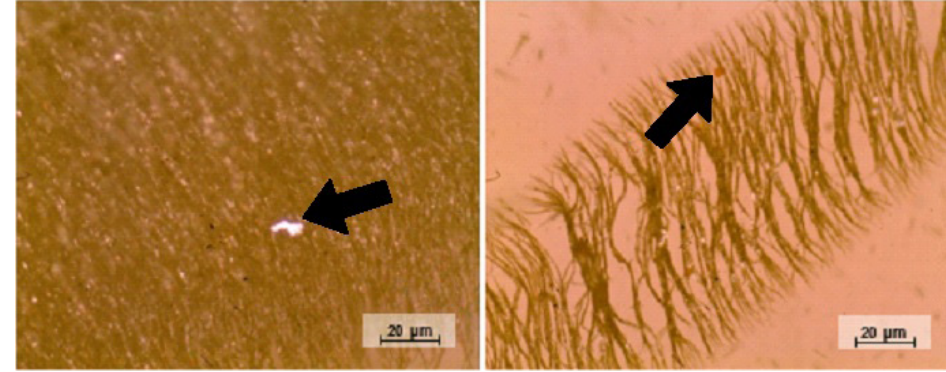
Figure 8. Contaminated blade with 2% left and 5% right. Source: Author’s own